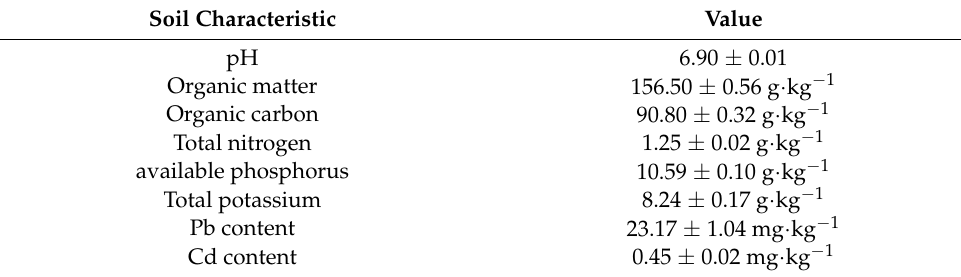
Table 1. Physicochemical characteristics of the experimental soil.